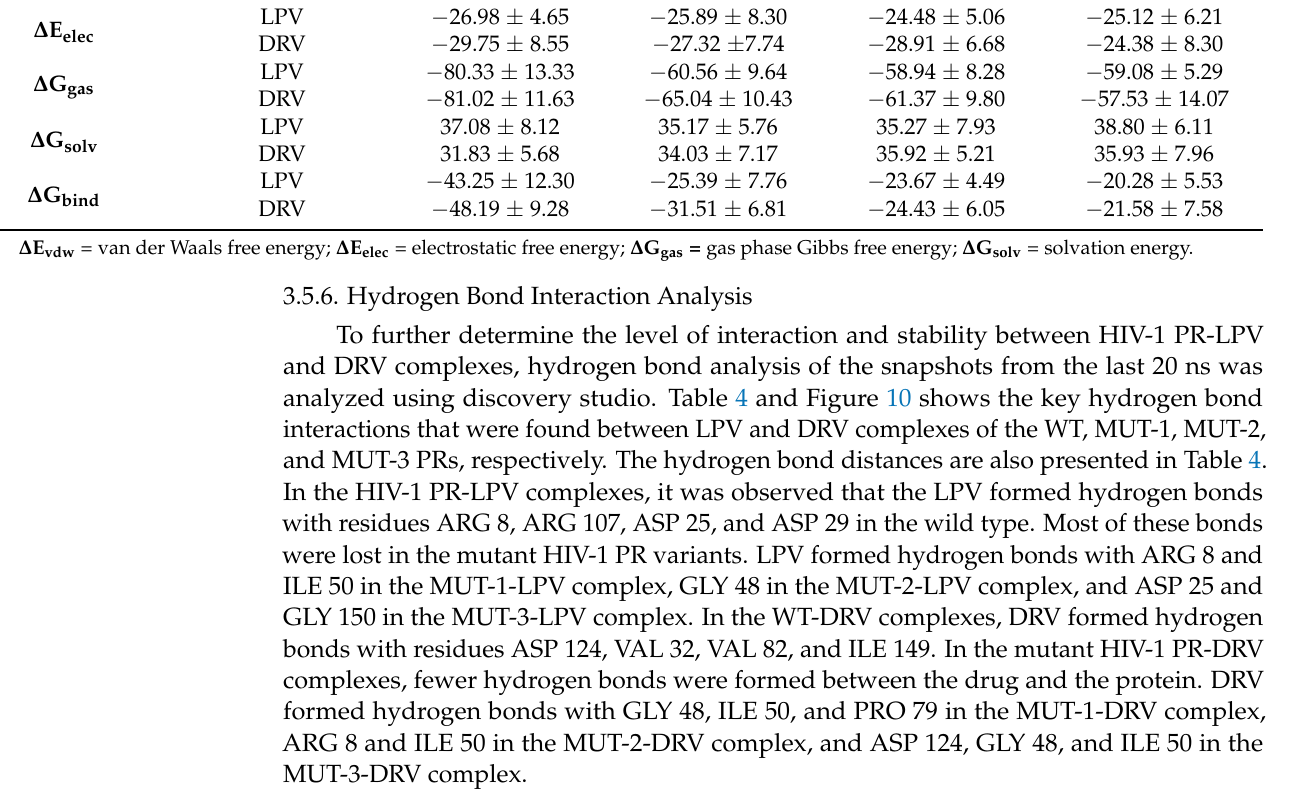
Table 4. Key hydrogen bond interactions between active site residues of WT, MUT-1, MUT-2, and MUT-3 with LPV and DRV. Hydrogen Bond Interaction